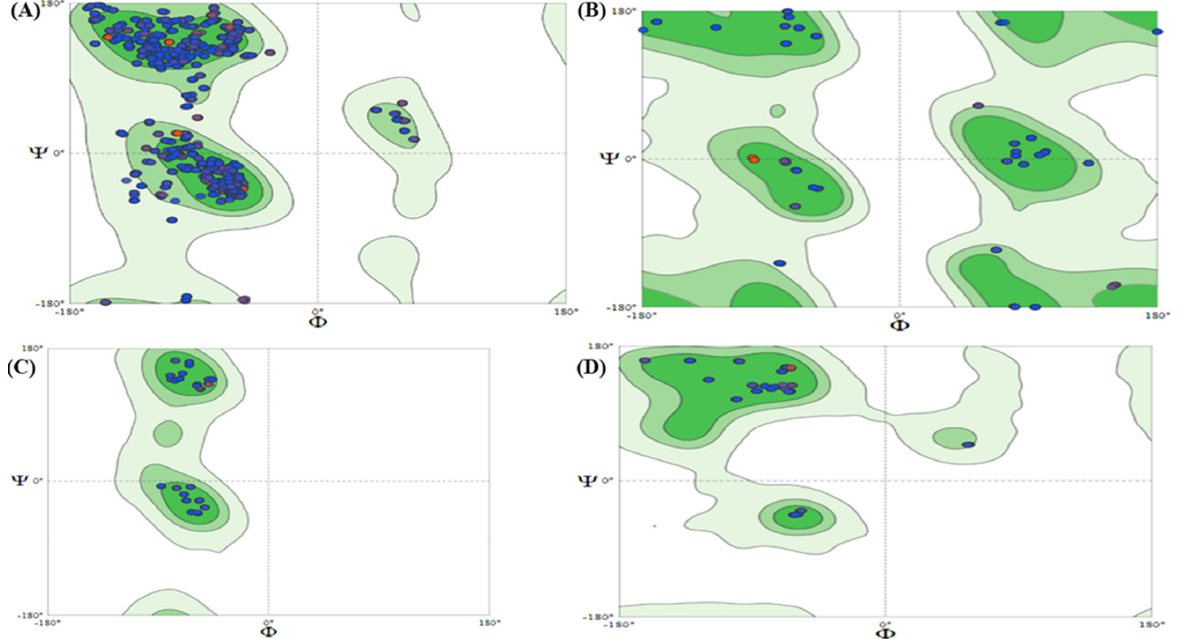
Figure 4. Ramachandran Plots of G6PD: ( A ) All chains, ( B ) Glycine, ( C ) Proline and ( D ) Pre ‐ proline. Table 5. Stereochemical properties and interacting residues of human G6PD protein.